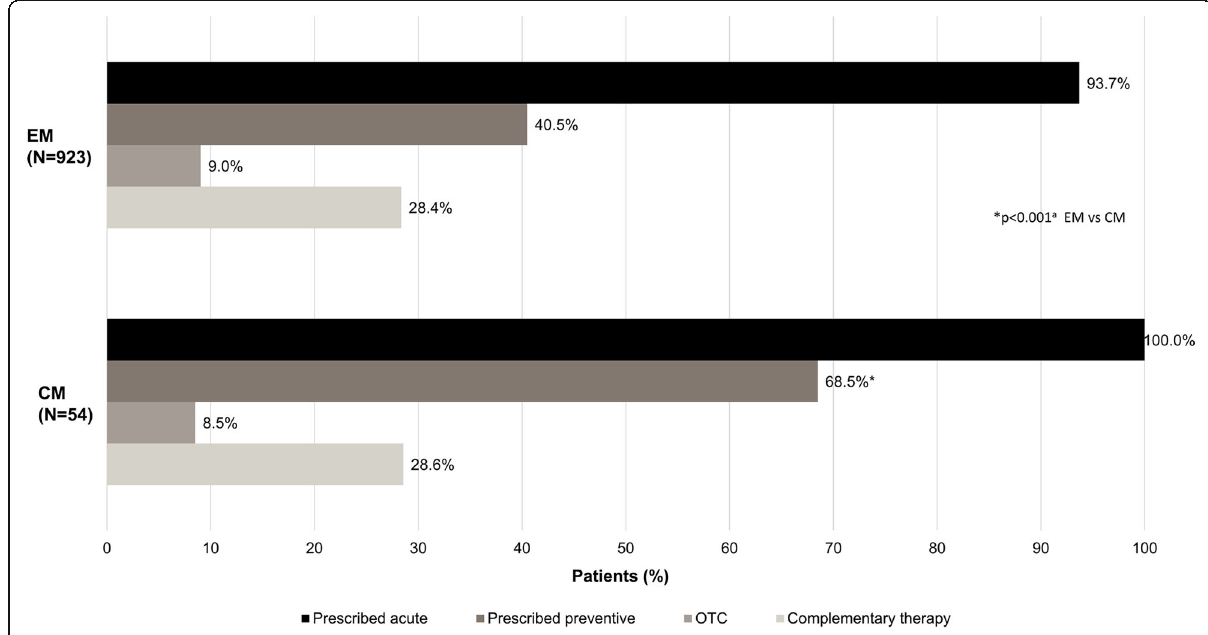
Fig. 1 Acute and prophylactic treatment of patients with episodic migraine (EM) and chronic migraine (CM): physician-reported data. Percentages are calculated as proportion of non-missing data. OTC, over the counter. a Chi-squared